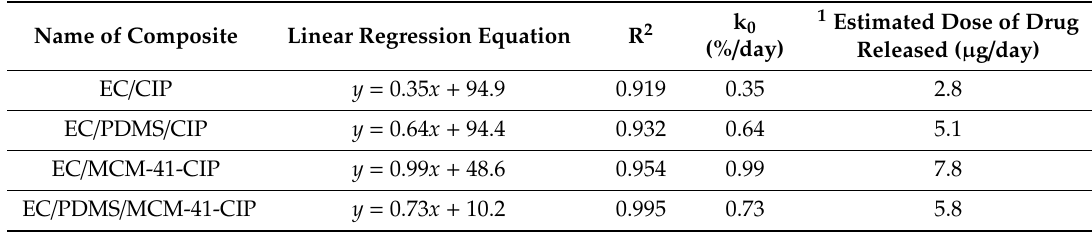
Table 3. The zero-order kinetics of obtained